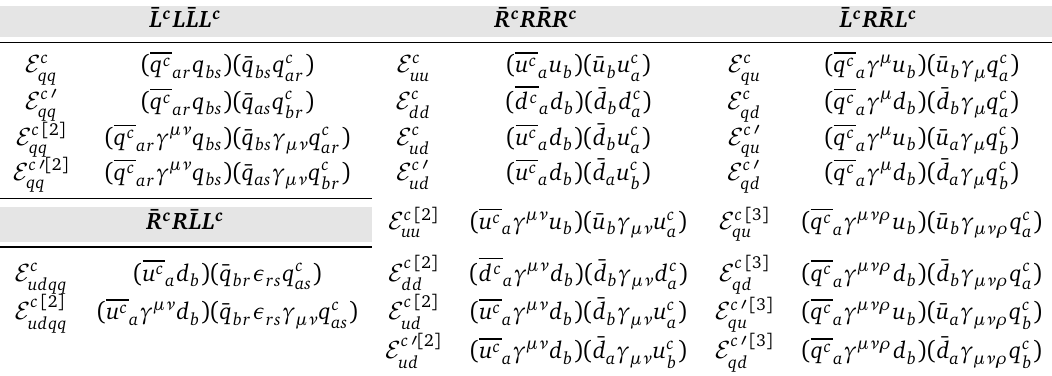
Table 8: Evanescent operators with four fermions involving only quarks and featur- ing charge conjugation. We use the shorthand notation γ µ 1 ... µ n ≡ γ µ 1 ... γ µ n with no (anti)symmetrization.